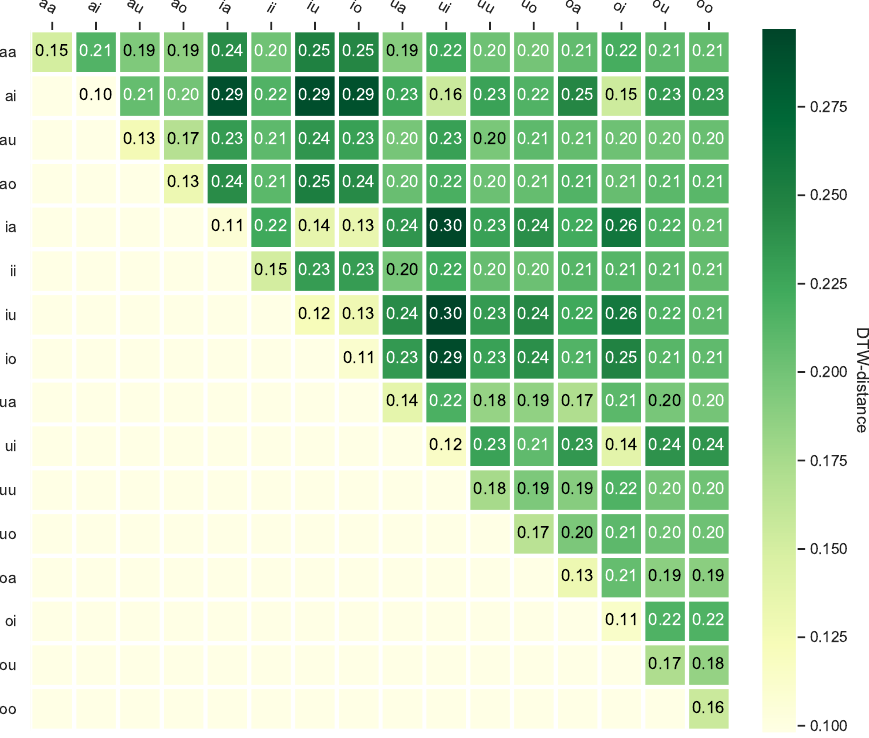
Figure A2. DTW awe calculated between samples from reference dataset. Lower values correspond to acoustically more similar